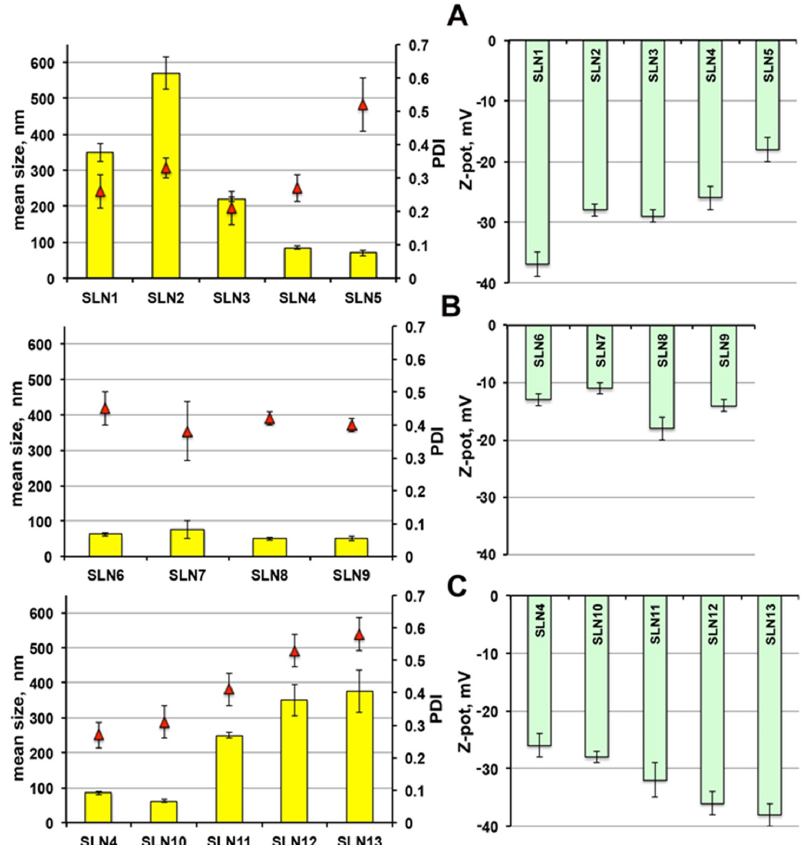
Figure 1. Physicochemical properties of empty SLNs in terms of mean size, polydispersity index (PDI) and Zeta potential: Scheme 1. SLN5 ( A ); SLN6-SLN9 ( B ); SLN10-SLN13 compared to SLN4 ( C ). See Table 2 for their composition.